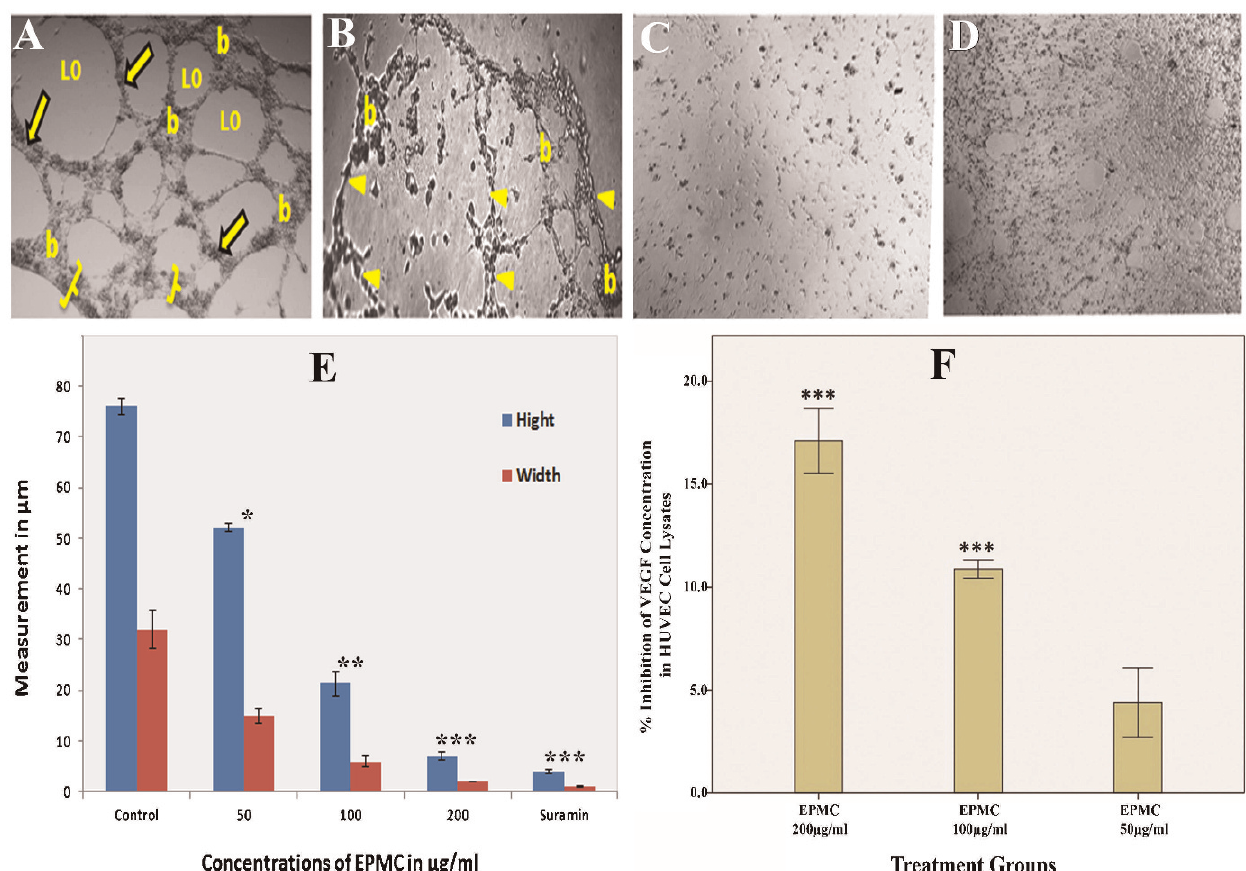
Figure 4 - Effects of ethyl- p -methoxycinnamate (EPMC) on tube formation and VEGF content in HUVECs. For the tube-formation assay, HUVECs (2 6 10 4 cells/well) were plated on Matrigel-precoated 96-well plates and treated with different concentrations of EPMC for 24 hours. Phase-contrast micrographs showing the effects of EPMC and suramin on the differentiation of HUVECs are presented. A ) Control group (vehicle treated), showing that the endothelial cells grown on the three-dimensional Matrigel media differentiated into branching structures to form capillary tube-like structures composed of multiple cells with intercellular spaces or lumens. The image clearly shows prominent areas covered with thick cells (brackets), tubes (arrows), loops (Lo), and branching points (b). B) Treatment with EPMC (50 m g/ml) resulted in a slight disruption of bridges (arrow head) and branching points. C) Treatment with EPMC (100 m g/ml) caused notable disorganization in the tube-like structures. Specifically, the improper development of lumens in the cell-cell connections can be seen. The apparent inhibitory effect of EPMC on the differentiation of HUVECs is also noticeable, and the affected tubes and network can be clearly seen. D ) Treatment with suramin (100 m g/ml) caused the complete abrogation of the bridges in the tube-like structures, which is evident by the absence of cell-covered areas (brackets in Figure A), tubes, and branching points. E ) Graphical depiction of the dose-dependent inhibitory effect of EPMC on the height and width of the capillary-like structures in HUVECs. F ) Graphical representation of the percent inhibition of vascular endothelial growth factor (VEGF) level in HUVEC lysates by EPMC. All values are represented as the mean ¡ SEM ( n =6); ** and *** indicate significant differences of p , 0.01 and p , 0.001, respectively, compared with the